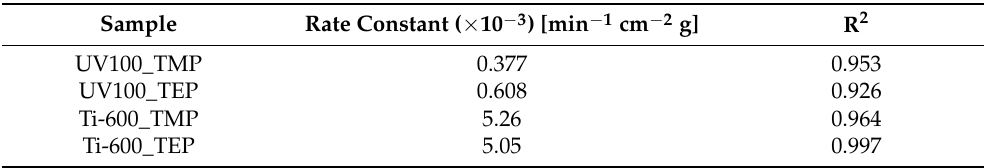
Table 1. Adsorption rates of TMP and TEP on sulfated TiO 2 and pure TiO 2 . Rate constants for OP adsorption were calculated from the integrated absorbance for UV100_TMP (1530–1450 cm − 1